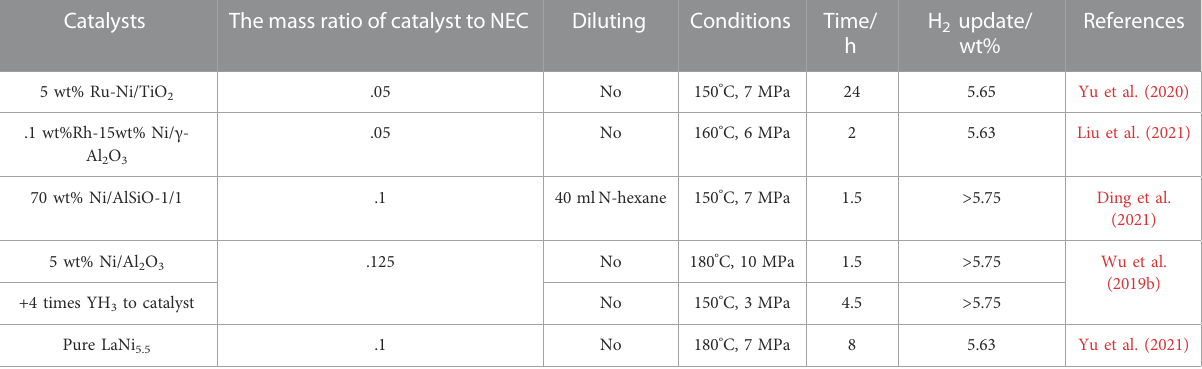
TABLE 1 Catalytic performance of nickel-containing hydrogenation catalysts